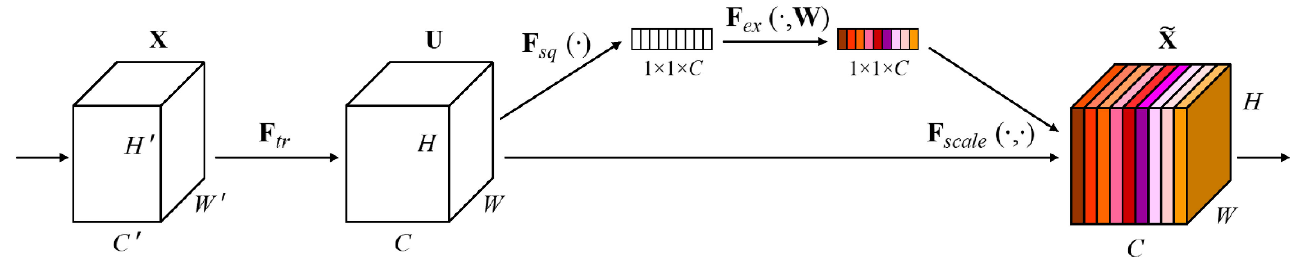
Figure 2. The basic structure of the attention-based DCNN [35].